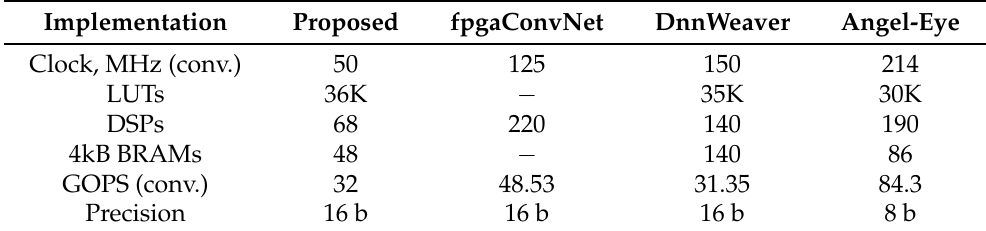
Table 2. Comparison of the proposed CNN accelerator to the state-of-the-art fpgaConvNet [35], DnnWeaver [34], and Angel-Eye [36] implementations on the same Z-7020